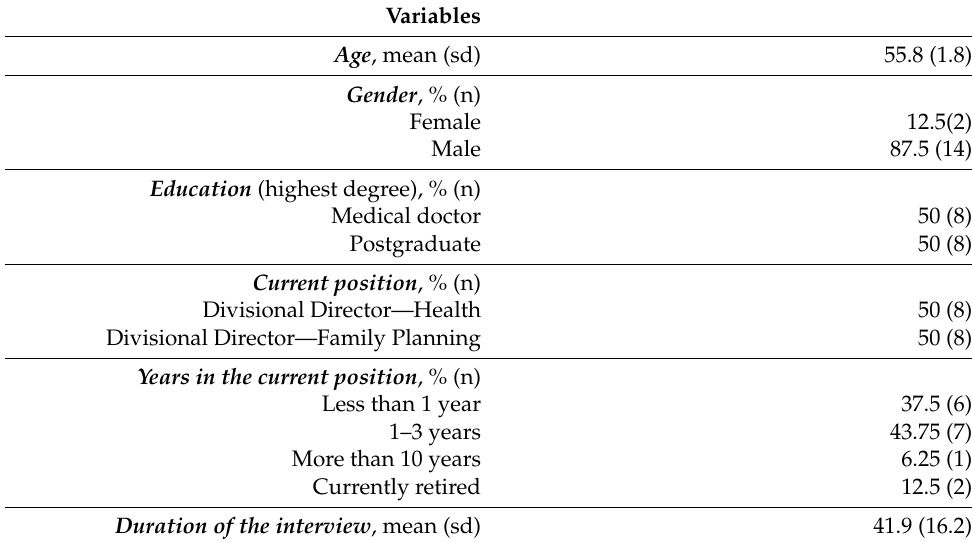
Table 1. Characteristics of the key